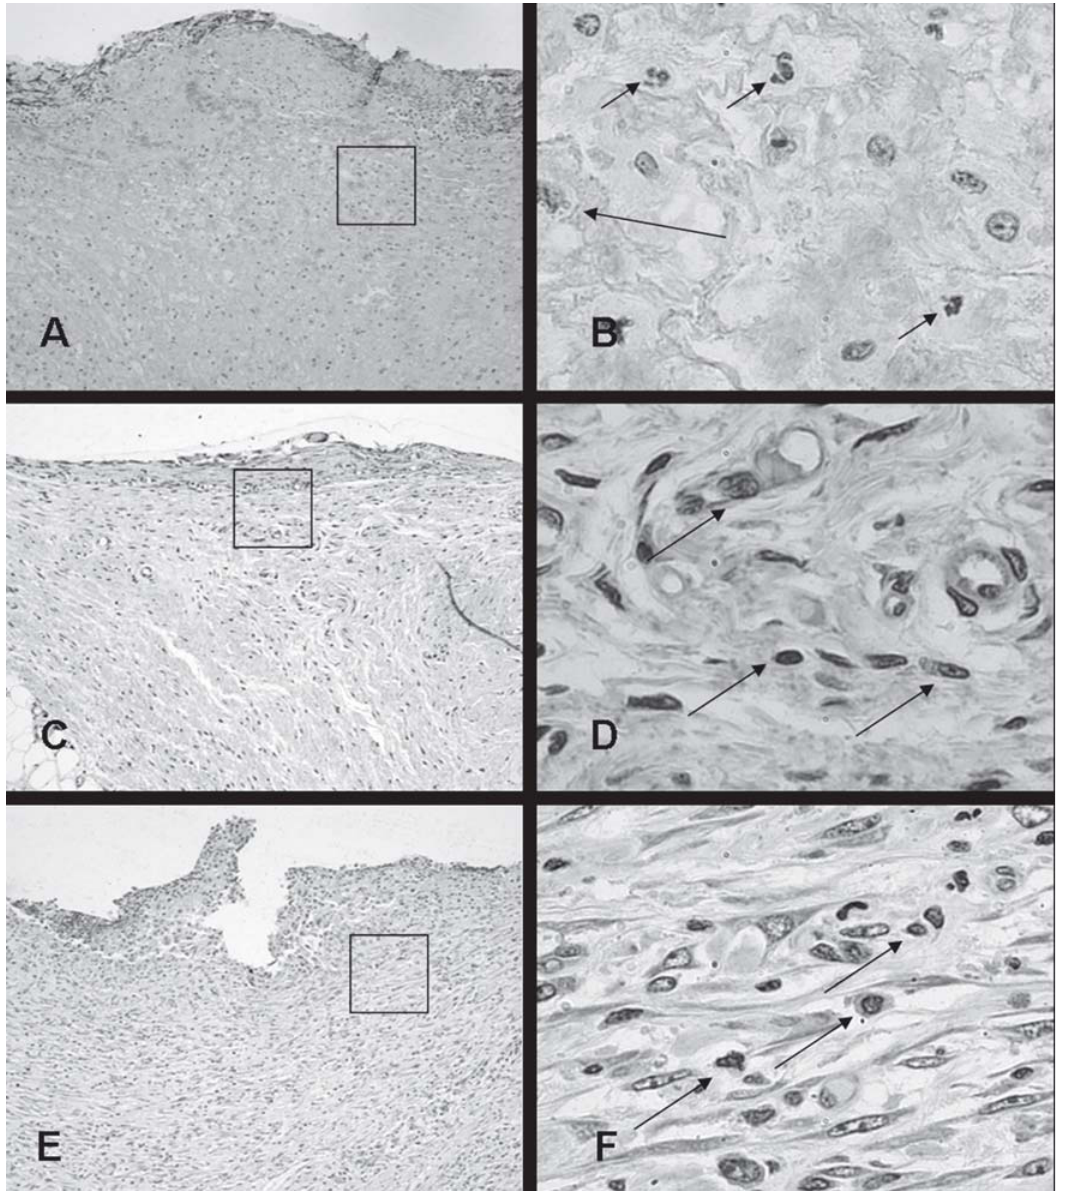
FIGURE 2- Rat subcutaneous tissue reaction to AH-Plus. A severe inflammatory reaction was observed on the 3rd day - HE 50x (A). Greater magnification showing that the tissue was infiltrated with neutrophils (small arrows) and macrophages (large arrows) - HE 400x (B). The intensity of reaction was milder on the 7th day and the tissue was more organized with formation of connective fibers - HE 50x (C). Greater magnification showing chronic cells, such as macrophages, plasma cells and lymphocytes (arrows) - HE 400x (D). On the 30th day, the capsule was still not completely formed - HE 50x (E). Greater magnification showing a more severe reaction than that observed on the 7th day with the presence of chronic cells (arrows) - HE 400x